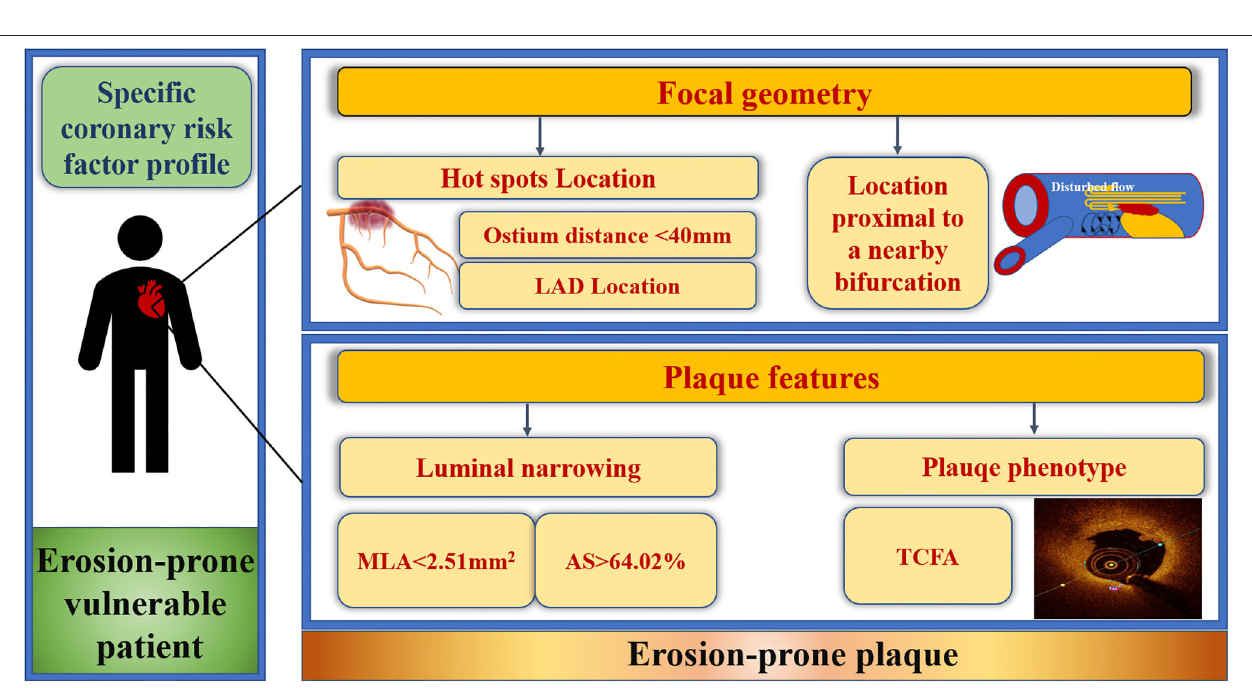
FIGURE 6 | Focal geometry and characteristics of erosion-prone plaques. Culprit plaque erosions selectively developed at predisposed areas within the coronary artery tree and exhibited specific features with certain focal geometry that can be used for risk-stratifying high-risk erosion-prone plaques in erosion-prone vulnerable STEMI patients. Culprit plaque erosion tended to cluster within the “hot spots,” defined as distance from the ostium to the MLA < 40mm in the LAD. LAD location, distance from coronary ostium < 40mm, proximal to a nearby bifurcation, MLA < 2.51 mm 2 , AS > 64.02% and underlying TCFA of the culprit lesion were predictors of culprit plaque erosion. AS, area stenosis; LAD, left anterior descending artery; MLA, minimal lumen area; STEMI, ST-segment elevation myocardial infarction; TCFA, thin-cap